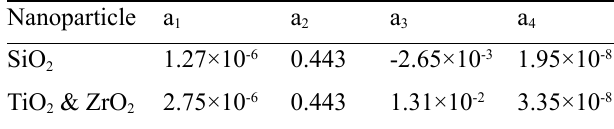
Table 7. The coefficients of the Predictive model.